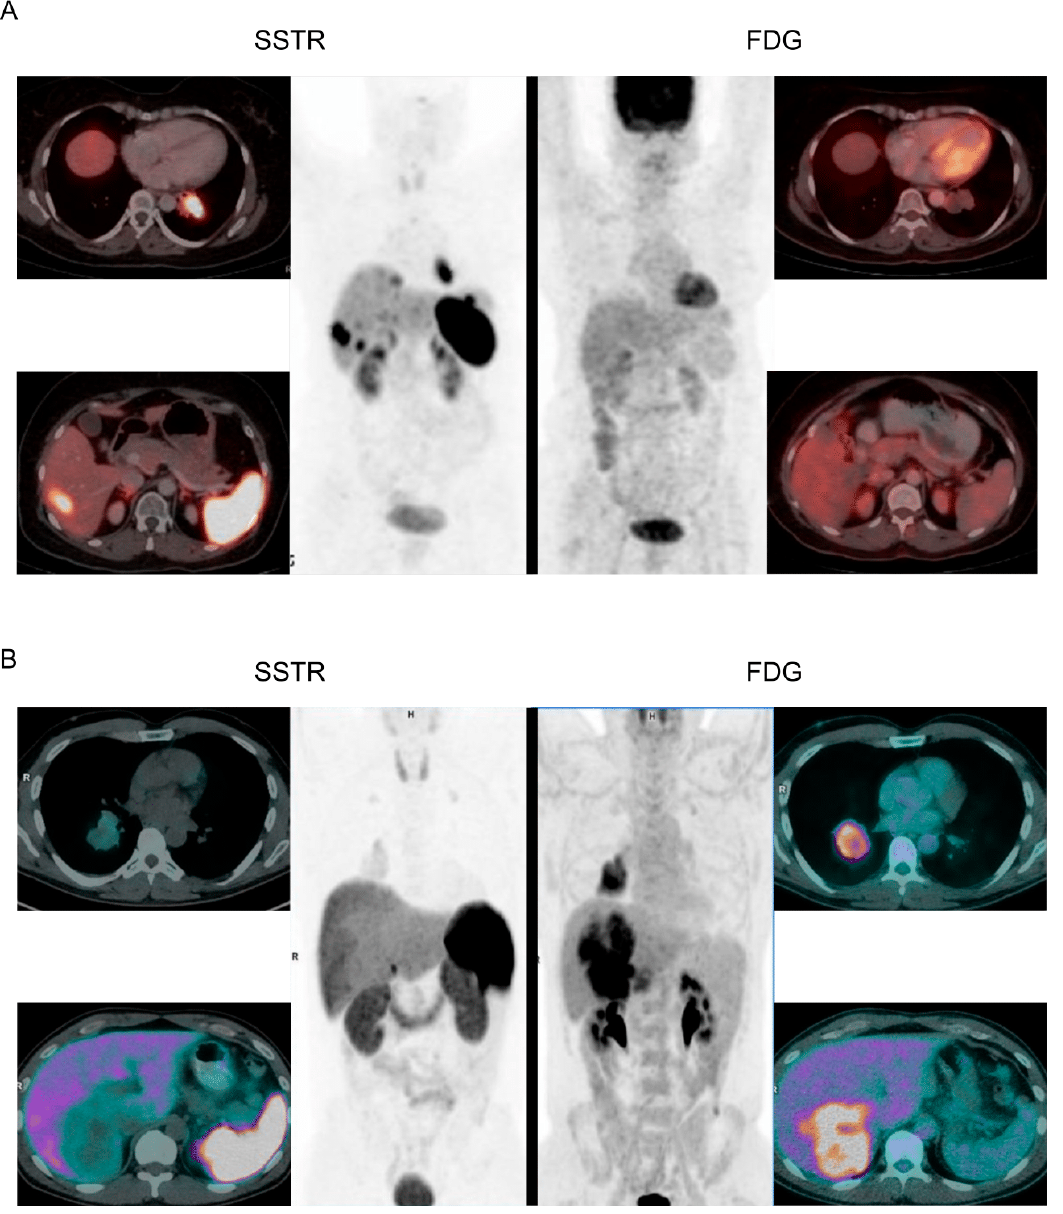
Figure 2. Functional scans of L-NETs and L-NECs. ( A ): A patient with L-NET was scanned with both a somatostatin analog (SSTR) scan and a glucose analog scan (FDG). The SSTR scan shows high uptake of somatostatin in the primary tumor and in a liver metastasis, while the FDG scan shows no uptake of FDG in the primary tumor and does not reveal the liver metastasis. ( B ): A patient with L-NEC was scanned with both an SSTR scan and an FDG scan. The FDG scan shows high uptake of FDG in the primary tumor and in a large conglomerate of liver metastases, while the SSTR scan shows no uptake of somatostatin in the primary tumor and does not reveal the liver metastases. Adapted from Purandara et al. and Chan et al. [32,33].